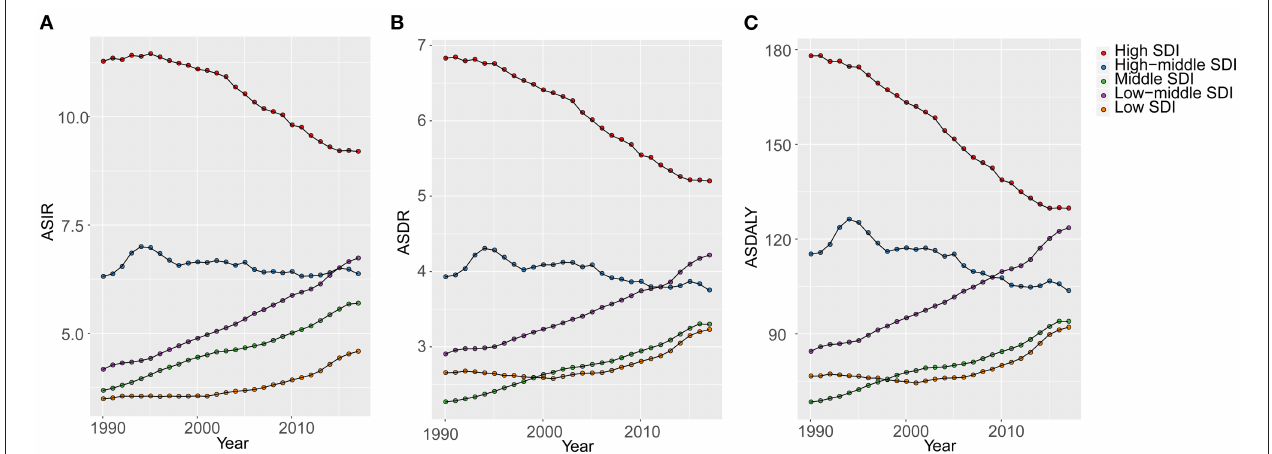
FIGURE 2 | The changes of age-standardized rates of different SDI quintiles from 1990 to 2017 (per 100,000). (A) ASIR, age standardized incidence rate; (B) ASDR, age standardized death rate; (C) DALY, disability adjusted life-year. SDI, socio-demographic index; GBD, global burden of diseases.